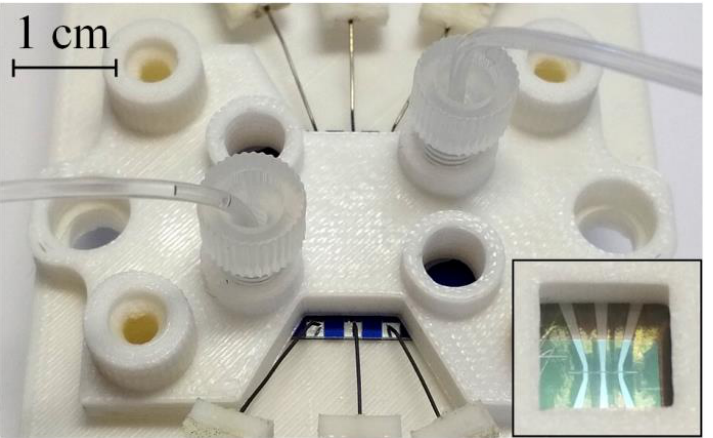
Figure 6. A micropump mounted in the holder. The probes are connected to the contact pads and the microfluidic tubing is connected to the inlet and outlet ports. The inset shows the bottom side of the holder with a square opening.